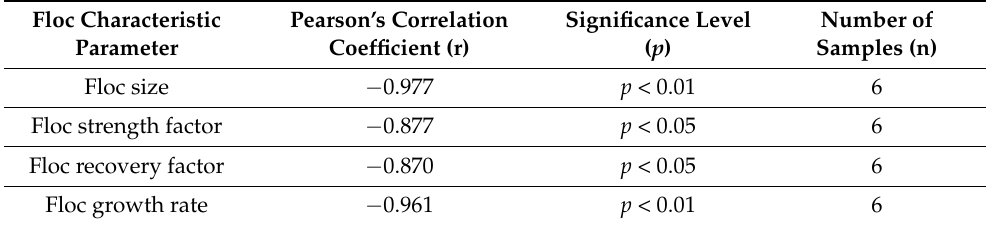
Table 1. Correlation analysis between DOC and floc size, floc strength factor, floc recovery factor, and floc growth rate.